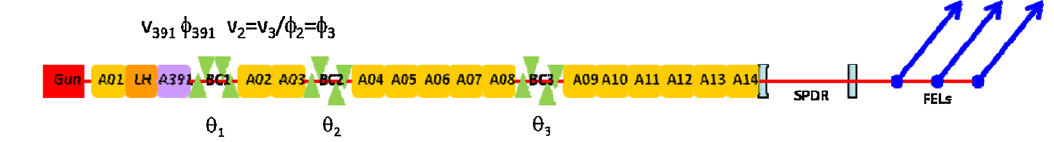
FIG. 1. Layout of the NLS linac with three bunch compressors and naming conventions for the parameters used in the optimization.